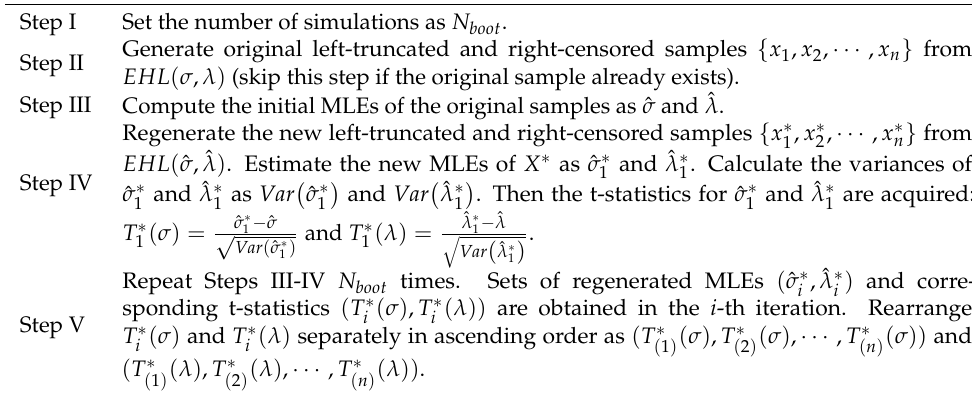
Algorithm 2 Establishing bootstrap-t confidence